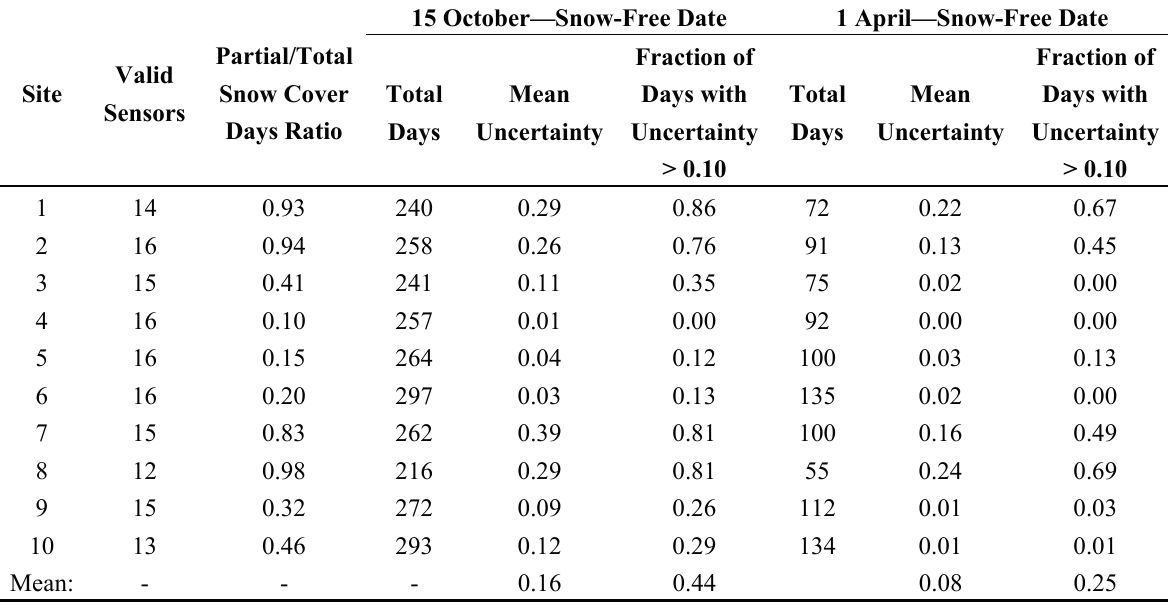
Table 6. Snow cover fraction uncertainty metrics for each 60 m grid cell. Uncertainty is expressed in terms of snow cover fraction ranging from 0 to